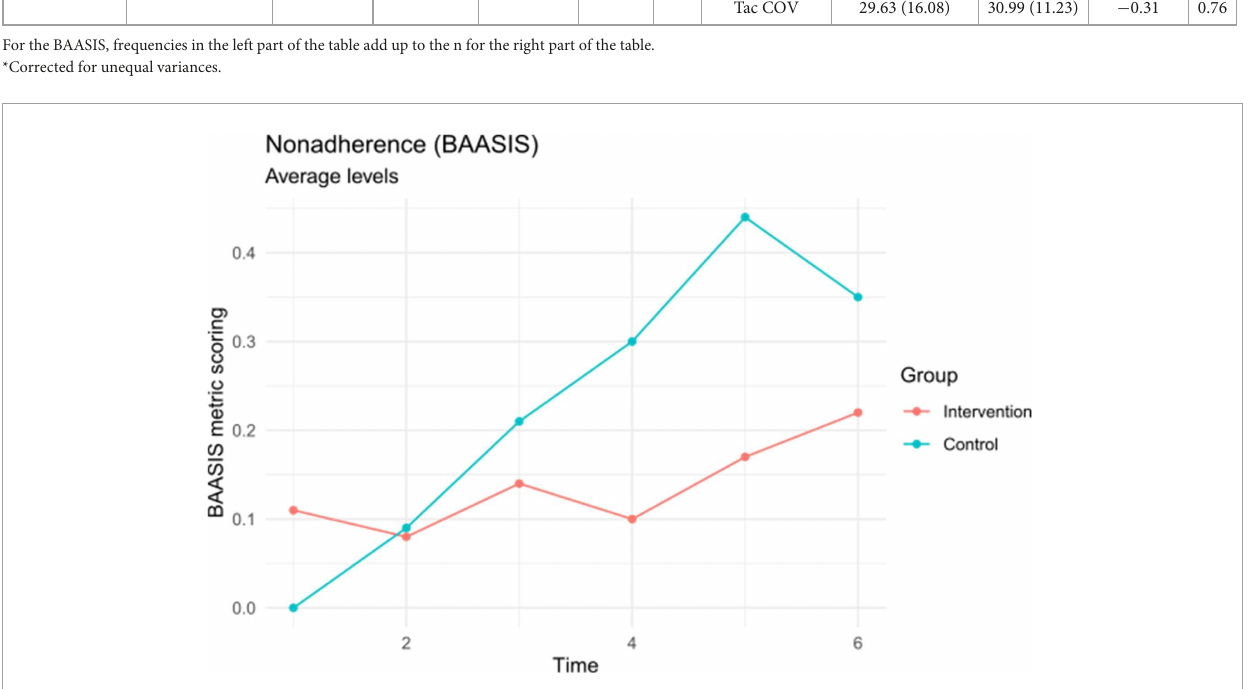
impact of interpersonal aspects of personality functioning for intervention